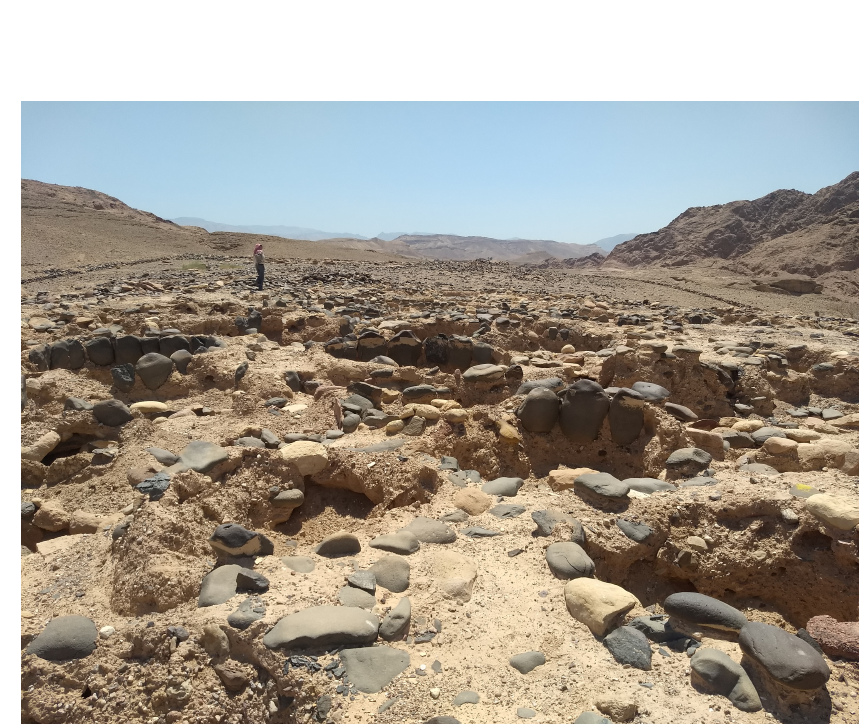
Figure 10 Iron Age graves at Wadi Fidan 40. Photo by the author.